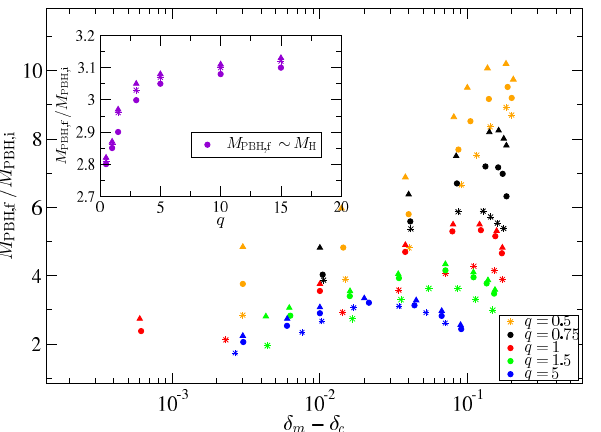
Figure 19. Accretion effect on the final PBH mass measured as the ratio M PBH, f / M PBH, i in terms of δ m − δ c ( q ) for different profiles with w = 1/3. Stars correspond to Equation (83) with λ = 0, circles to Equation (82), and triangles to Equation (86). The ratio M PBH, f / M PBH, i for PBHs with M PBH, f (cid:39) M H is shown in the subplot.